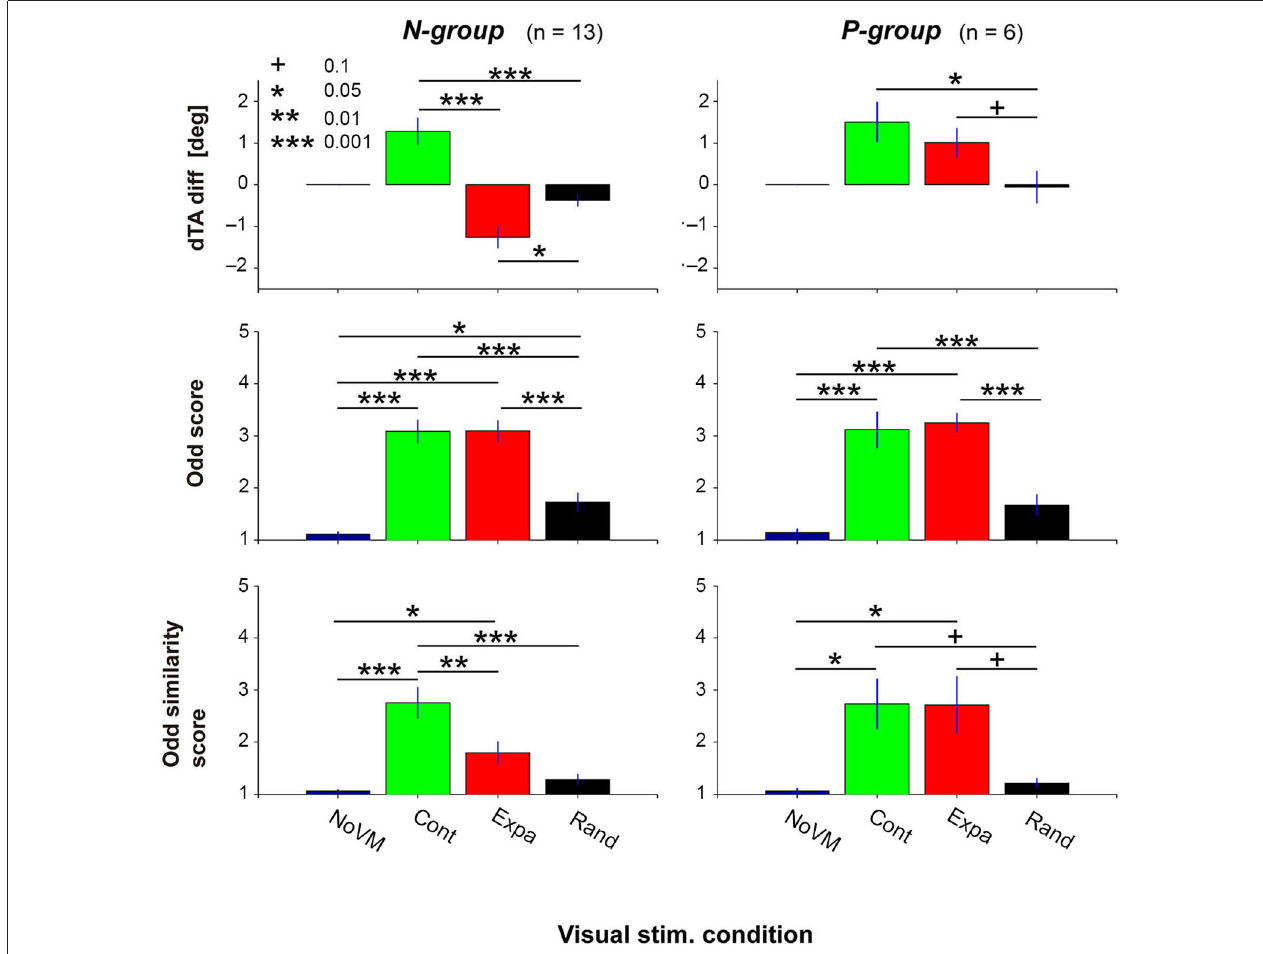
the Expa stimulus; the P-group those who showed positive dTA-diff for the Expa stimulus. Each bar denotes the mean of the values of the first 10 trials in the corresponding condition, and its error bar denotes SE across participants. “+” p < 0.1, “*” p < 0.05, “**” p < 0.01, “***” p <